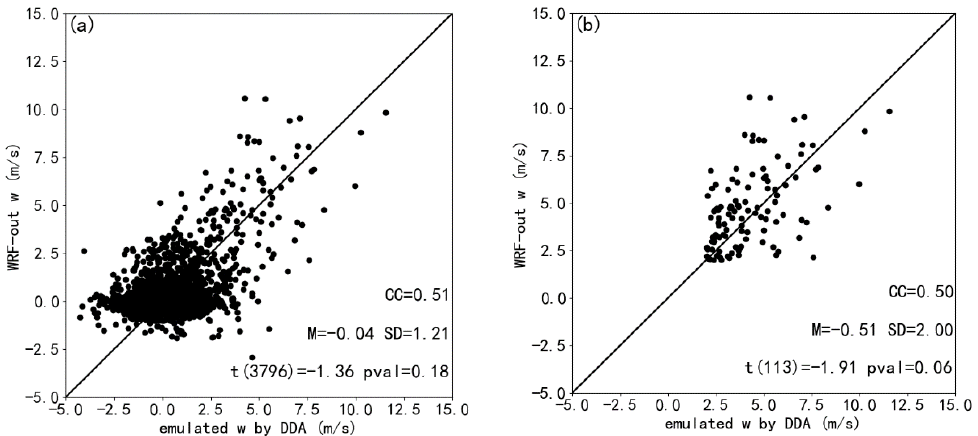
Figure 7. The point-to-point statistical scatters of correlation between the emulated w by the DDA method and WRF-out w. ( a ) The analysis time is the same as Figure 6, 17:00, 18:00 and 19:00. ( b ) The same as ( a ), except for filtering the points that are emulated w values below 2 m/s or WRF-out w values below 2 m/s. CC is the correlation coefficient of two w. M is the mean of difference. SD is the standard deviation. The t and pval are the t-test results.